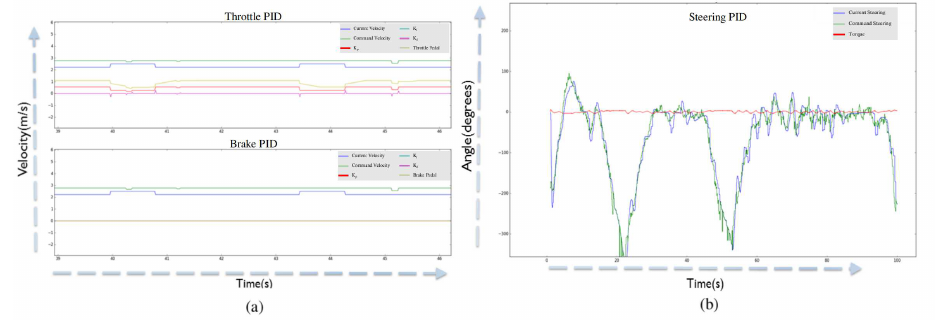
Figure 18. ( a ) The current velocity (from can-bus) and command velocity (from twist filter). It also shows the Throttle Pedal and PID parameters (Proportional, Integral and Derivative) (between 1 and − 1). ( b ) The graph of current steering and target steering values along with the torque information [24] (Best viewed in color).